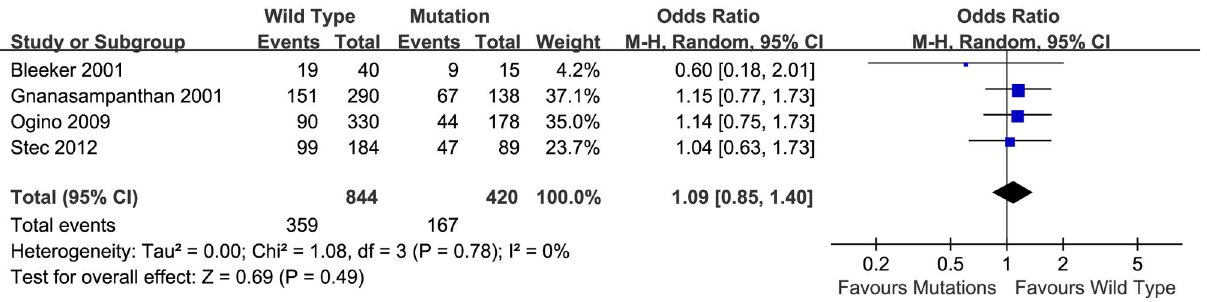
Figure 5. 5-year disease-free survival rate of wild type and mutant K-ras gene in patients received chemotherapy after rejecting Ahnen 1998.